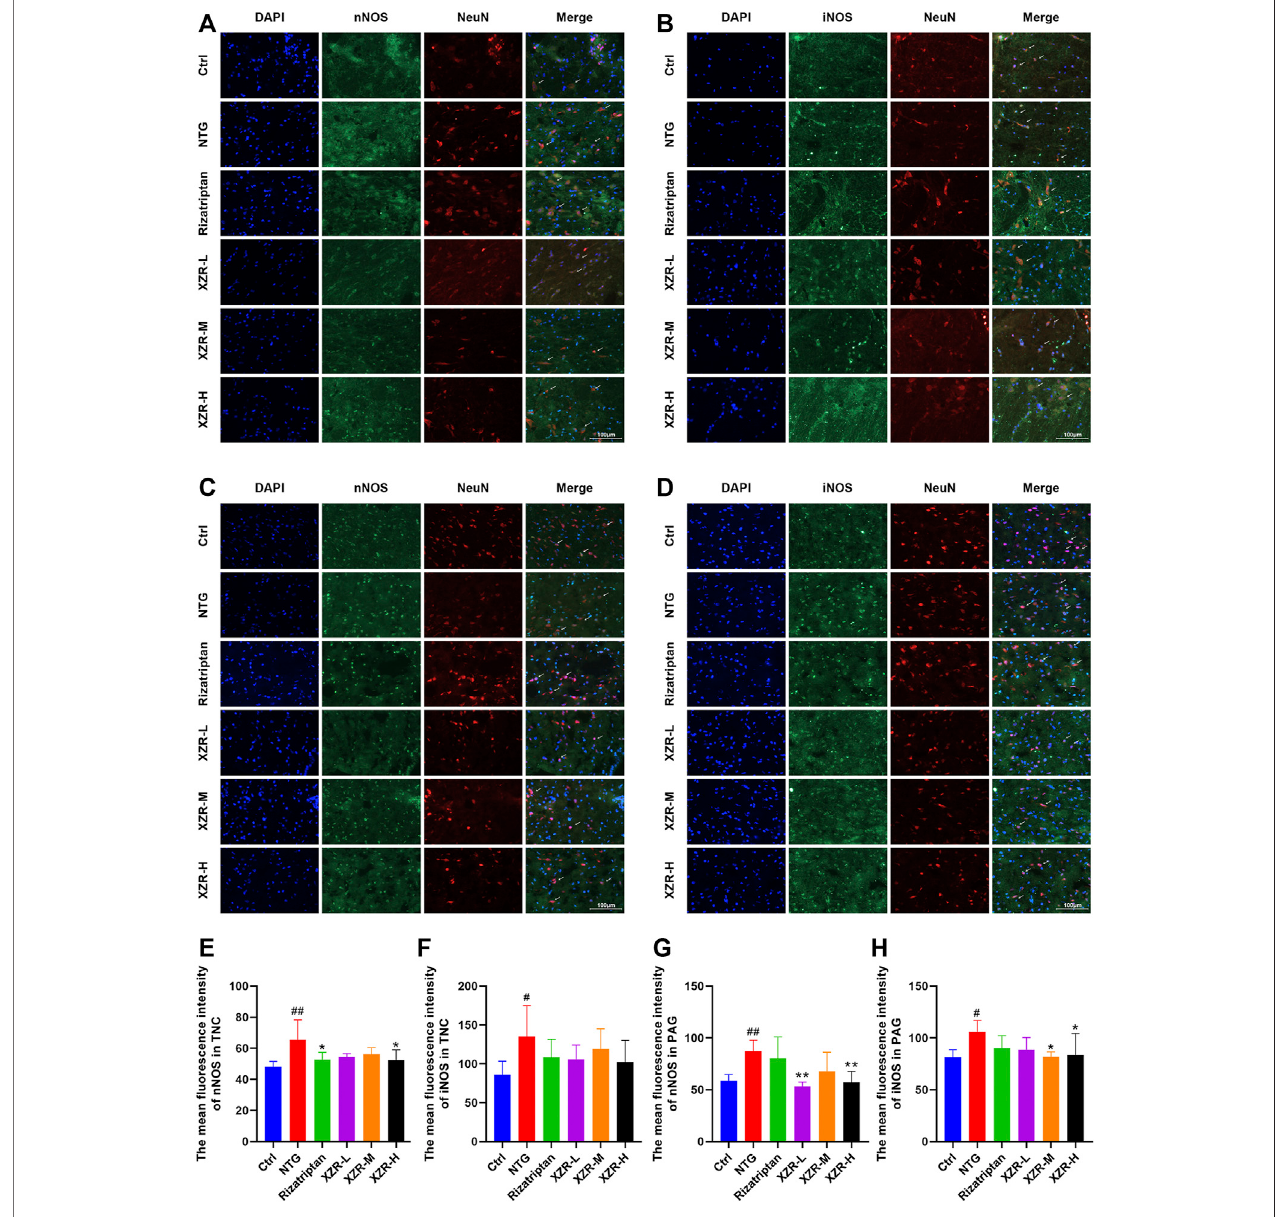
FIGURE 6 | XZR reduced the NOS expression in the TNC and PAG. (A,B) Immuno fl uorescence of nNOS and iNOS in the TNC and (C,D) PAG. Immuno fl uorescence double-label, DAPI (blue), nNOS and iNOS (green),and NeuN (red), scale bar = 100 μ m. (E,F) The mean fl uorescence intensity ofnNOS and iNOS in the TNC. (G,H) The mean fl uorescence intensity of nNOS and iNOS in the PAG. Data are presented as the mean ± standard deviation, n = 6. # p < 0.05, ## p < 0.01 versus the control group, * p < 0.05, ** p < 0.01 versus the NTG group. XZR, Xiongshao Zhitong Recipe; TNC, trigeminal nucleus caudalis; NTG, nitroglycerin; PAG, periaqueductal